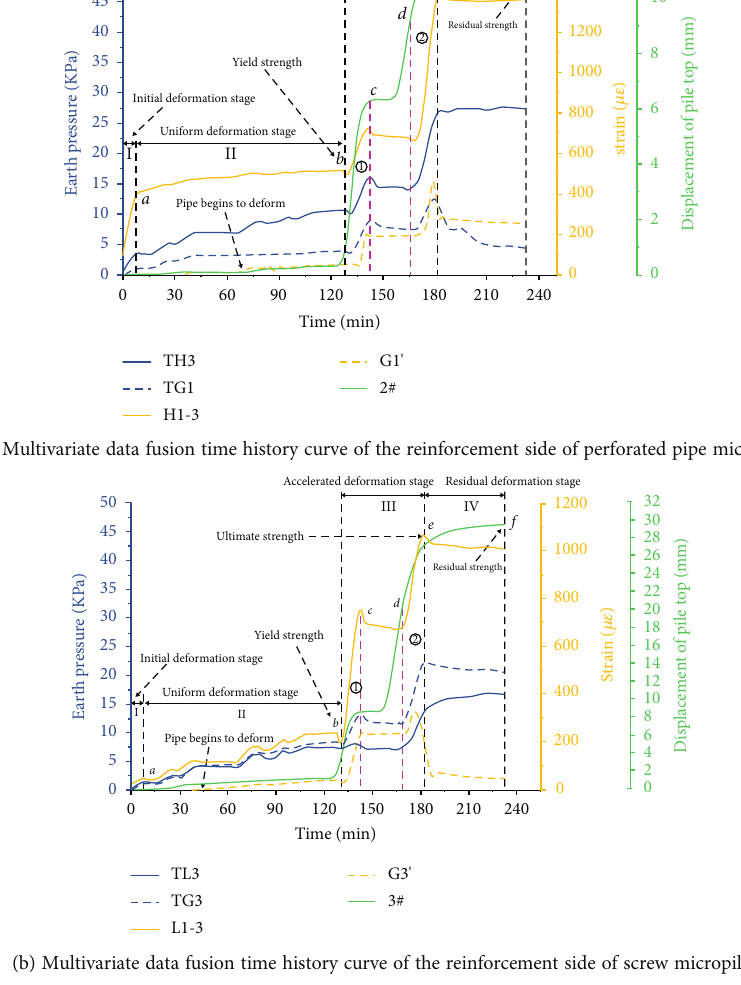
Figure 15: Cooperative deformation evolution process of landslide, micropile, and